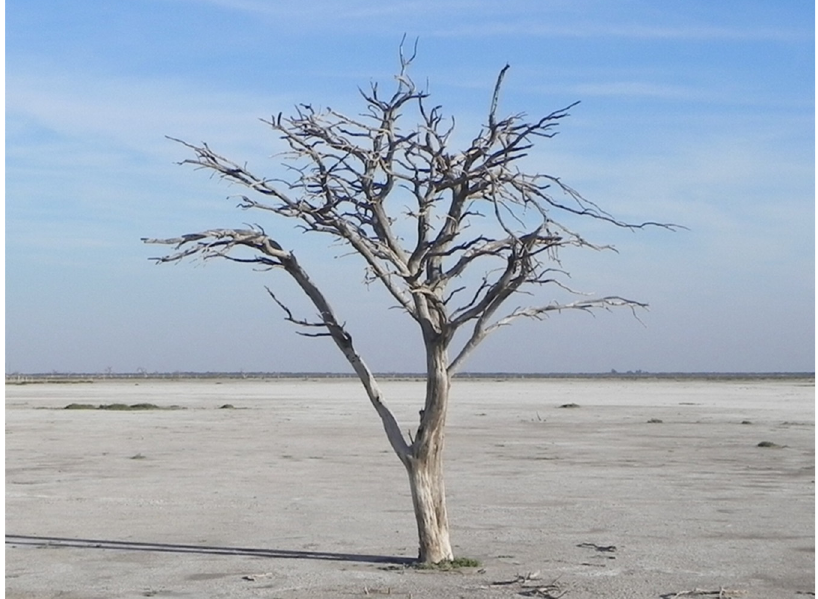
Fig 4. Dead tree from the original forest that surrounded the lake. The forest disappeared during the exceptional expansion during the 1972 – 2004